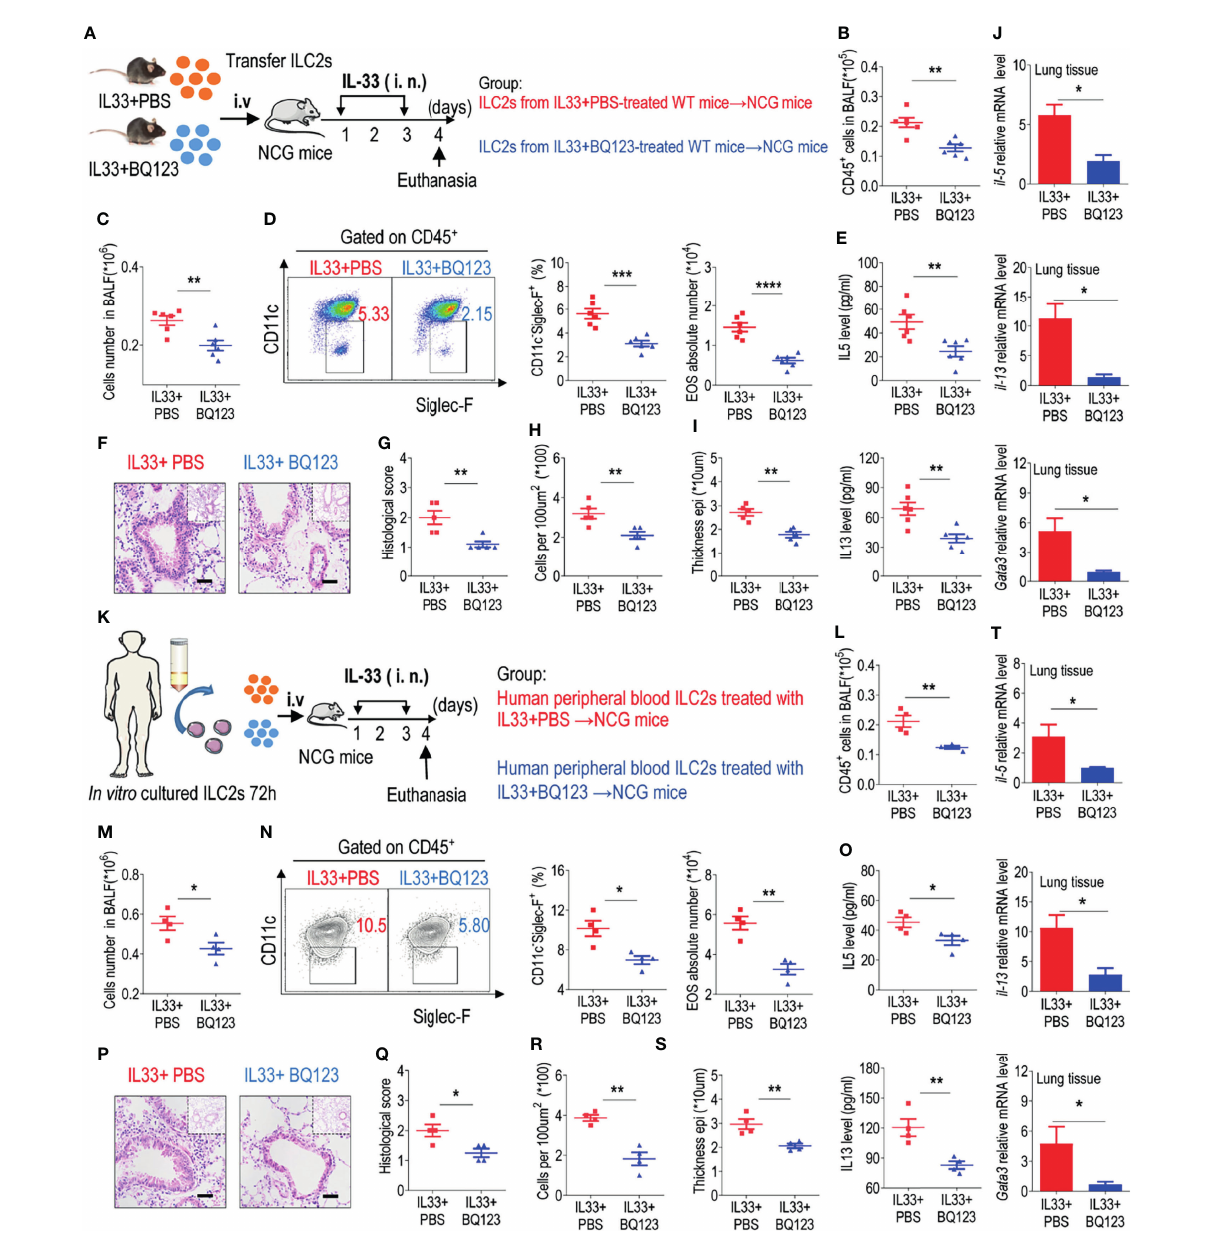
FIGURE 5 | BQ123 alleviated airway in fl ammation by impairing ILC2 function. (A, K) Experimental scheme. ILC2s (approximately 5 × 10 4 in 200 µL) were adoptively transferred intravenously into recipient NCG mice. Mice were intranasally challenged with IL-33 for three consecutive days, and the bronchoalveolar lavage fl uid (BALF) and lung tissues were analyzed on day 4. (B, L) The number of total CD45 + cells in BALF. (C, M) Absolute number of BALF. (D, N) Typical example of fl ow cytometry (left) and statistical results (right) of population and the absolute number of EOS in the BALF. (E, O) IL-5 and IL-13 levels in the BALF. (F – I, P – S) Representative hematoxylin and eosin (H&E) staining of lung sections and in fl ammation scores, as well as the in fi ltrating cells and airway epithelium thickness were shown. (J, T) mRNA expression levels of Il5 , Il13 , and Gata3 were evaluated; b -actin level was used for normalization, and the lowest expression level in the IL33 + BQ123 group was arti fi cially set to 1. Data are representative of two independent experiments (n = 6 for the IL-33 mouse model; n = 4 for the humanized IL-33 mouse model). *P < 0.05; **P < 0.01; ***P < 0.001; ****P < 0.0001. In all panels, individual results and mean ± standard error of the mean (SEM) are shown; statistical signi fi cance was determined using a two-tailed unpaired Student ’ s t-test (B – E, G – J, L – O, Q – T)